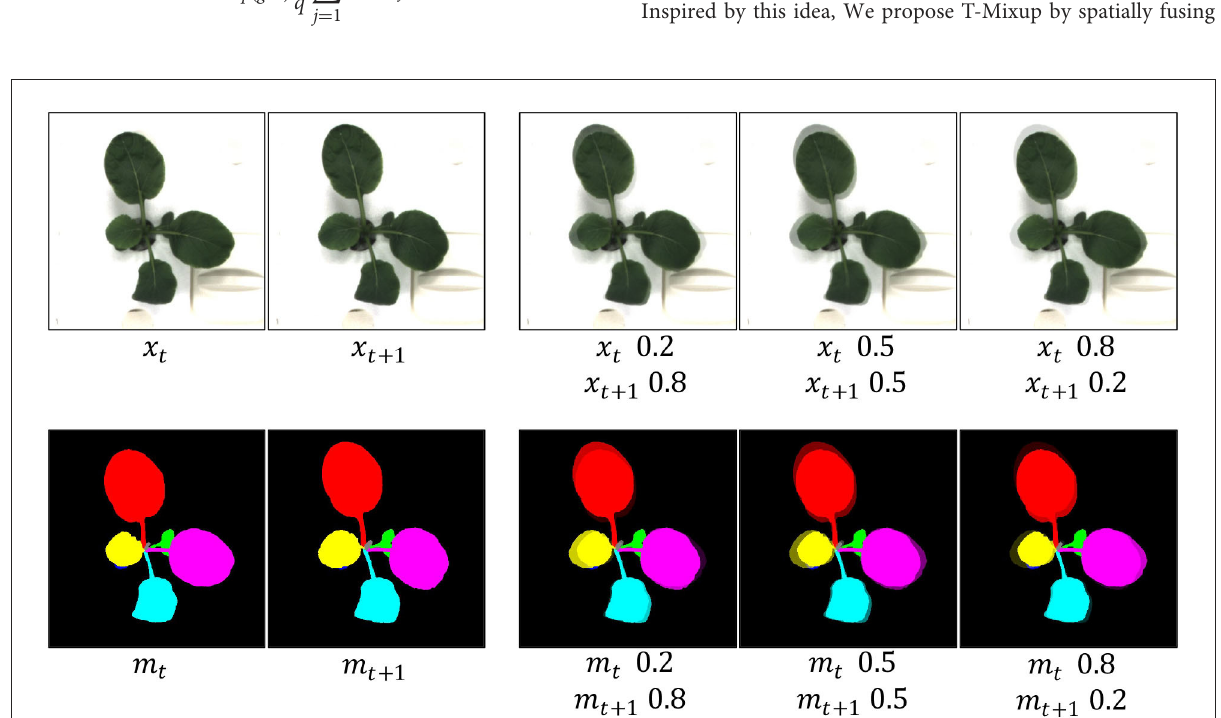
FIGURE3 Generated examples of T-Mixup with the different merged ratios. The augmented RGB images and instance masks are not natural. Therefore, we only use T-Mixup in a pretraining process, followed by a finetuning process for all layers.